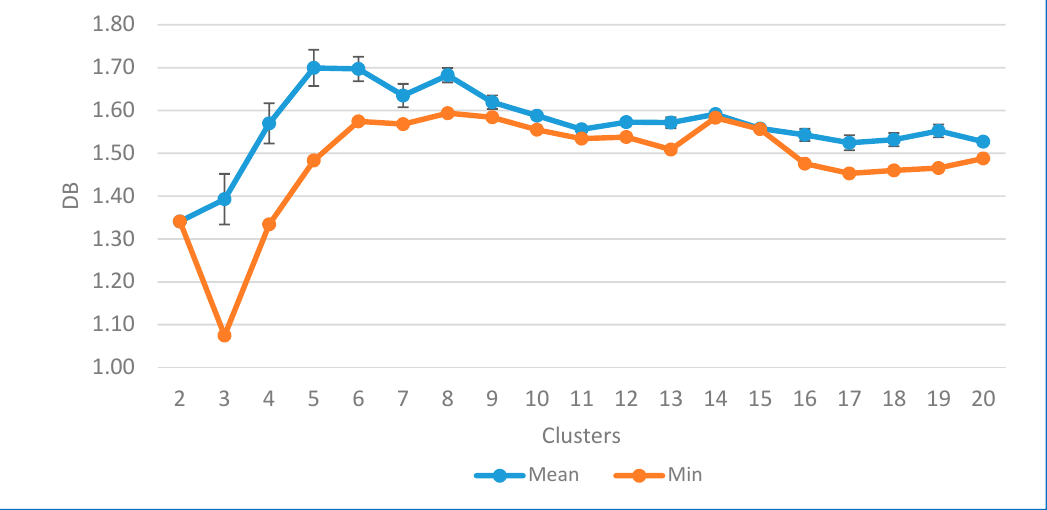
Figure 5. Davies Bouldin (DB) index values for TLS: DB mean with standard error and DB minimum.